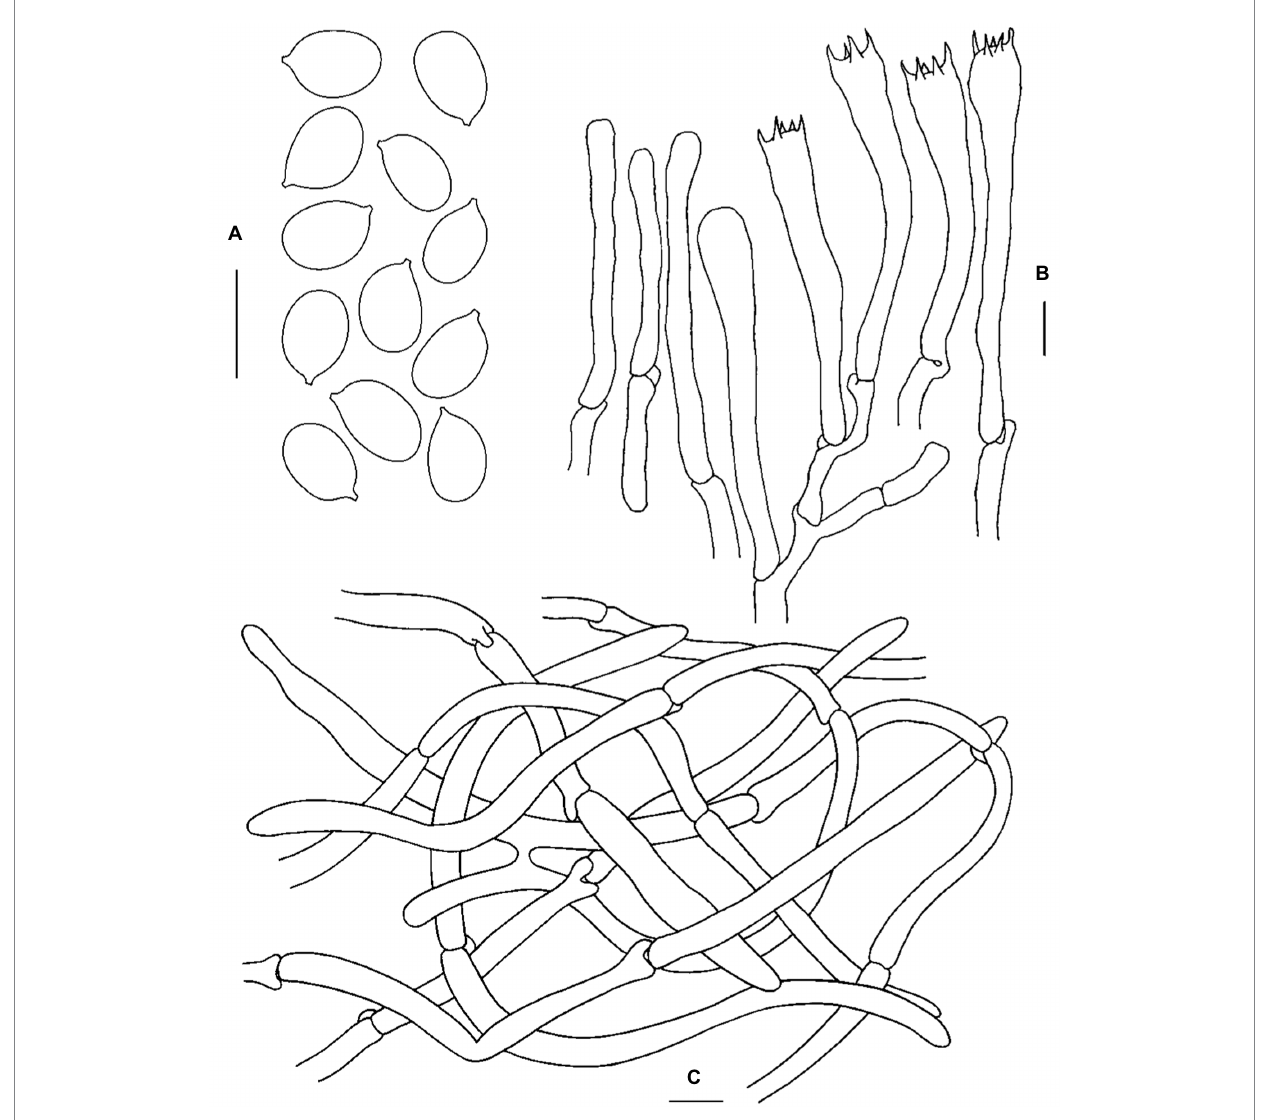
FIGURE 3 Microscopic features of Cantharellus bellus (FHMU2422, holotype). (A) Basidiospores. (B) Basidia. (C) Pileipellis. Scale bars = 10 μ m. Drawings by Y. Z.